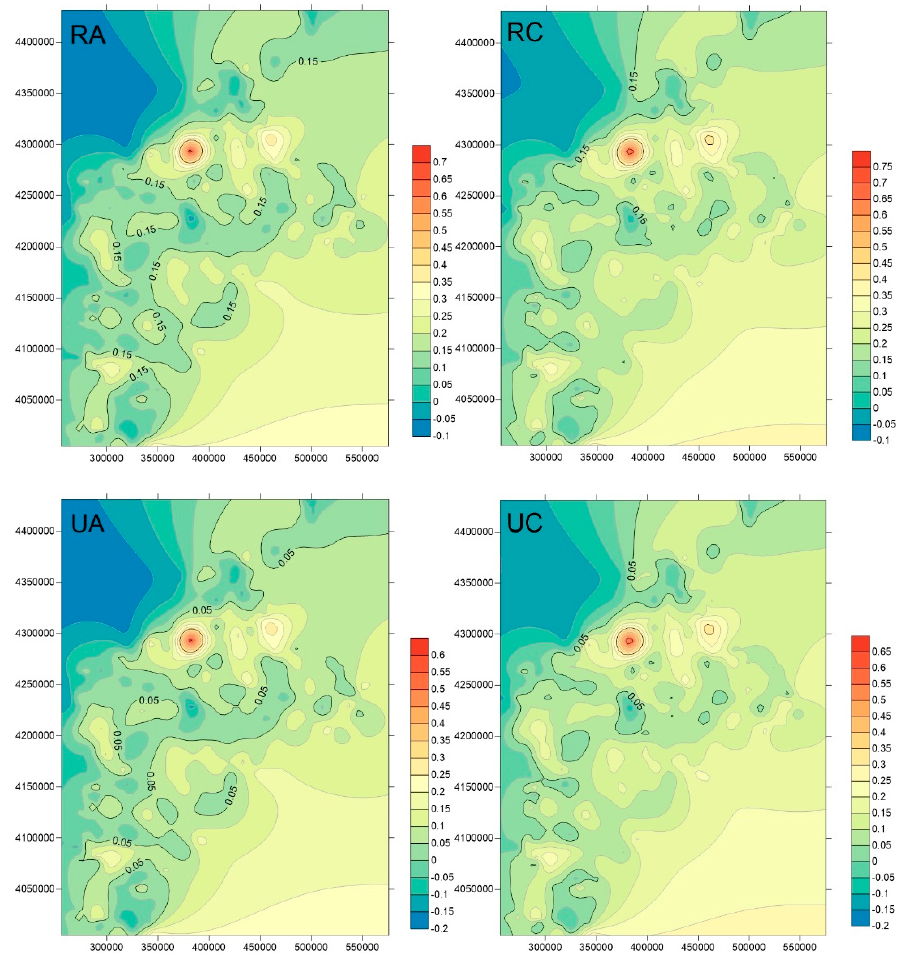
Figure 6. The contour map of the total target hazard quotients of rural and urban populations (RA = rural adults, RC = rural children, UA = urban adults, and UC = urban children).